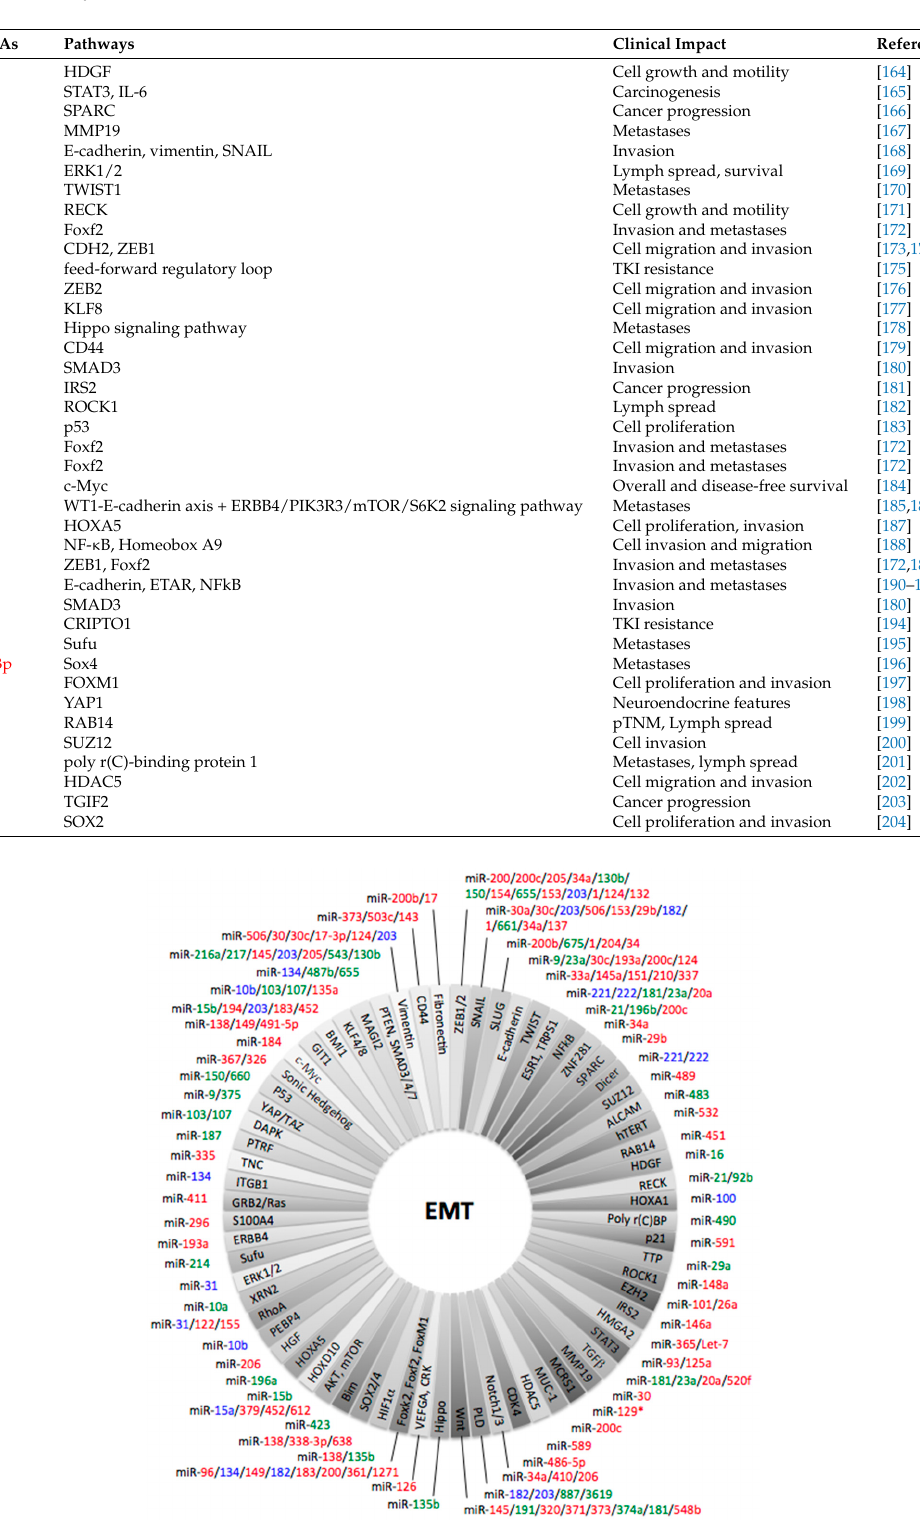
Table 2. List of EMT involved miRNAs based on NSCLC tissue samples and patients’ series studies, with details on the involved pathways and the clinical impact (green, promote EMT; red, suppress EMT) (TKI, Tyrosine-Kinase Inhibitor).